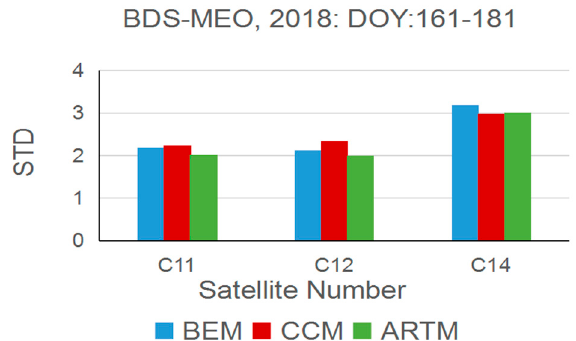
Figure 9. The STD of the satellite repeat shift time for the three methods for each satellite during the period DOY:161–181, 2018.